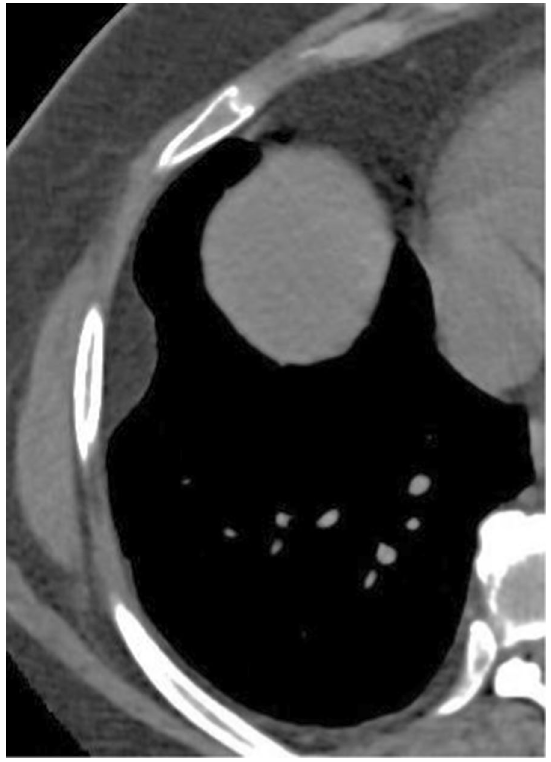
Fig. 2 54‑year‑old male patient complaining of dyspnea. Axial CT mediastinal window image showing an incidentally discovered